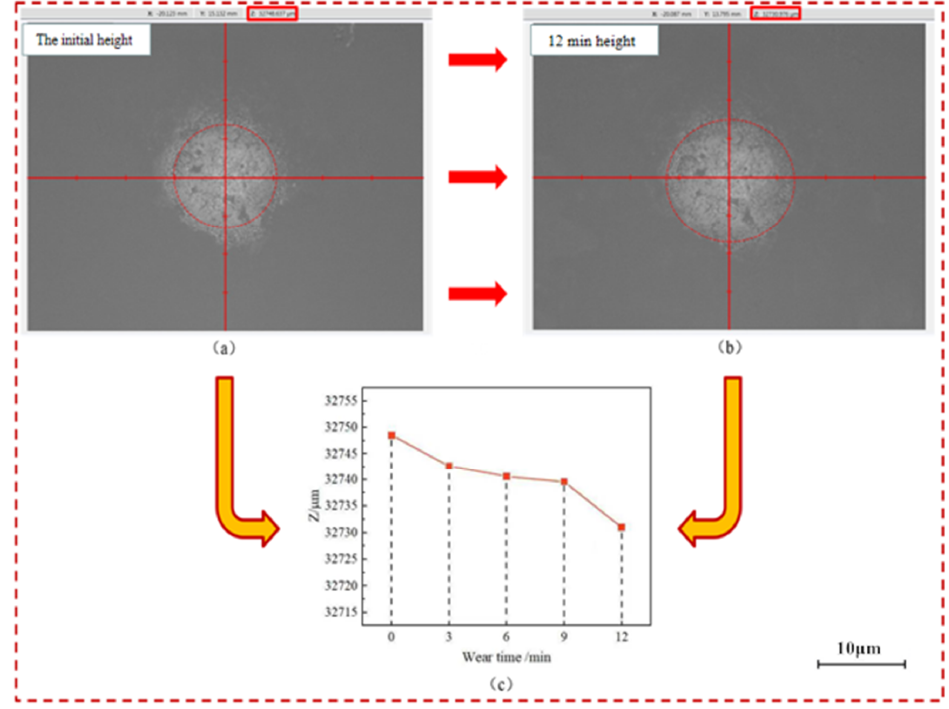
Figure 14. Normal displacement of the abrasive particles after wear. ( a ) Initial height morphology; ( b ) morphology after polishing for 12 min; and ( c ) change in abrasive grain concession height.